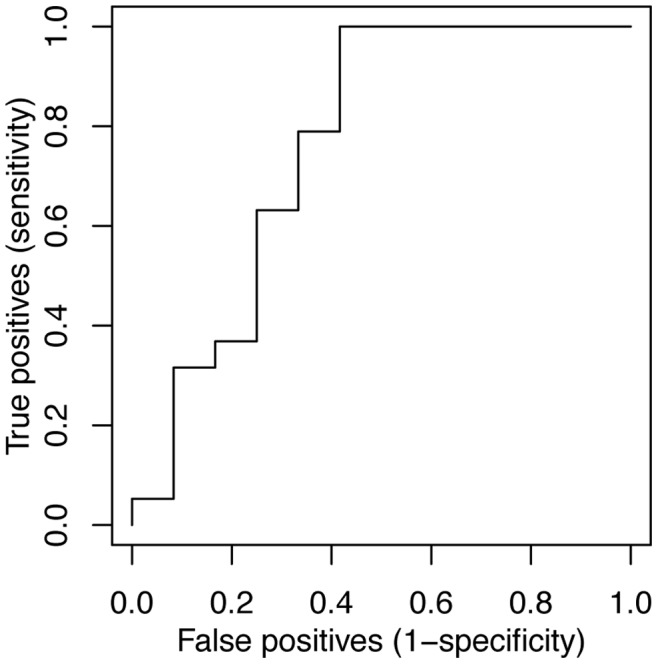
ROC analysis of the BRCA2 signature in the validation set.Each tumor was given a score that was a weighted sum of the mean centered gene expression levels for each gene in the signature. The validation set contained 19 BRCA2 and 12 BRCAX tumors. The AUC was 0.76.